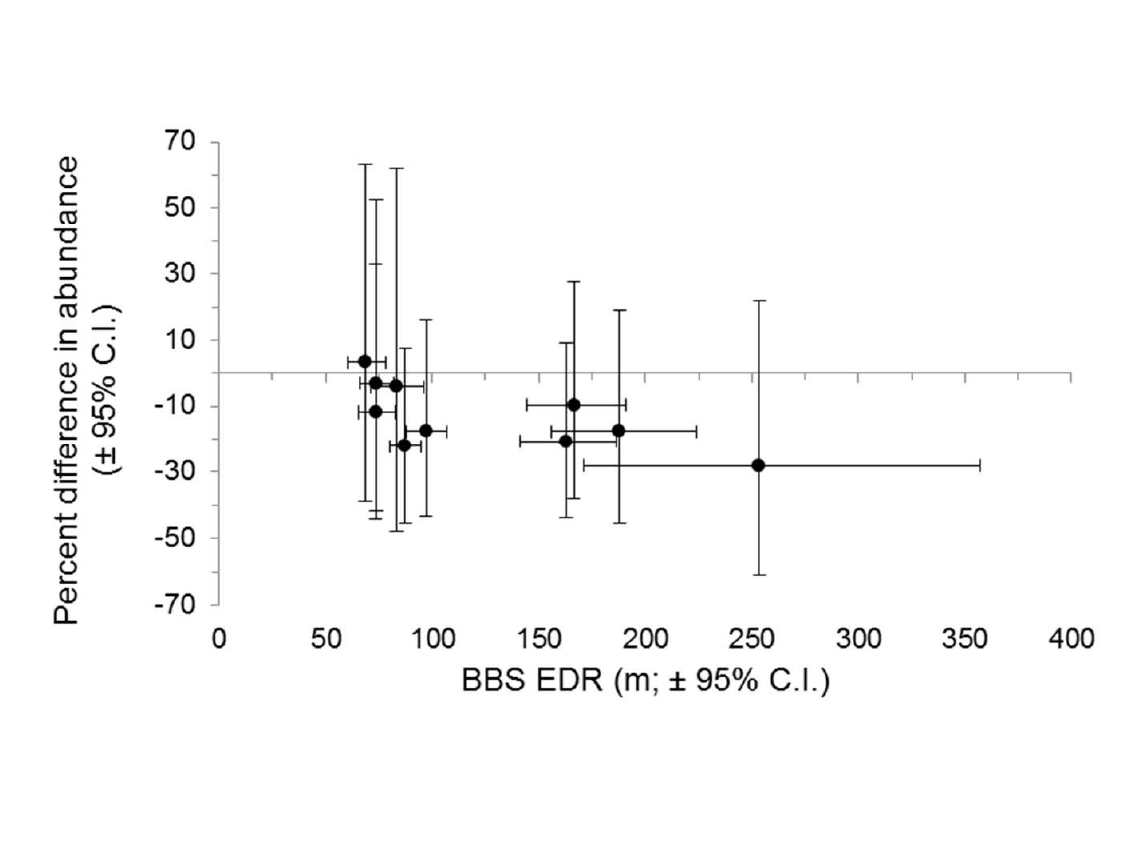
Figure A1.4. Relationship between BBS EDR (± 95% C.I.) and percent difference (± 95% C.I.) in relative abundance between on-road ARU BBS and forest-edge ARU BBS surveys (i.e. bias in detection). Each circle represents species-specific values. Bias values lower than 0 indicate higher counts for on-road ARU BBS surveys, while values higher than 0 indicate higher counts for forest-edge ARU BBS